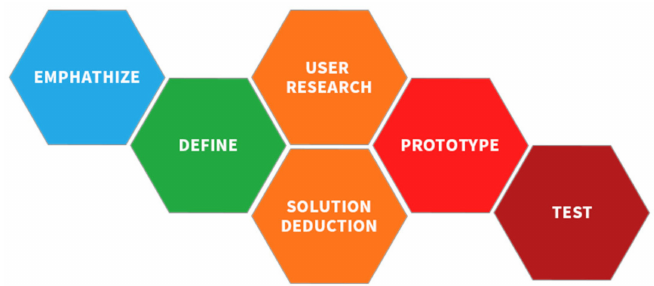
Figure 5. Improved design thinking.